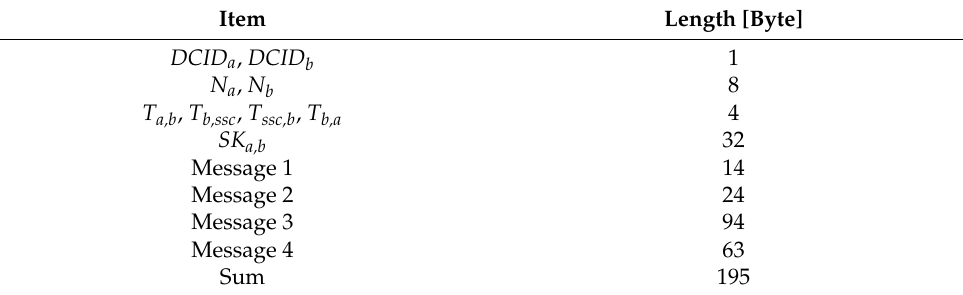
Table 3. Message length of the authentication scheme.